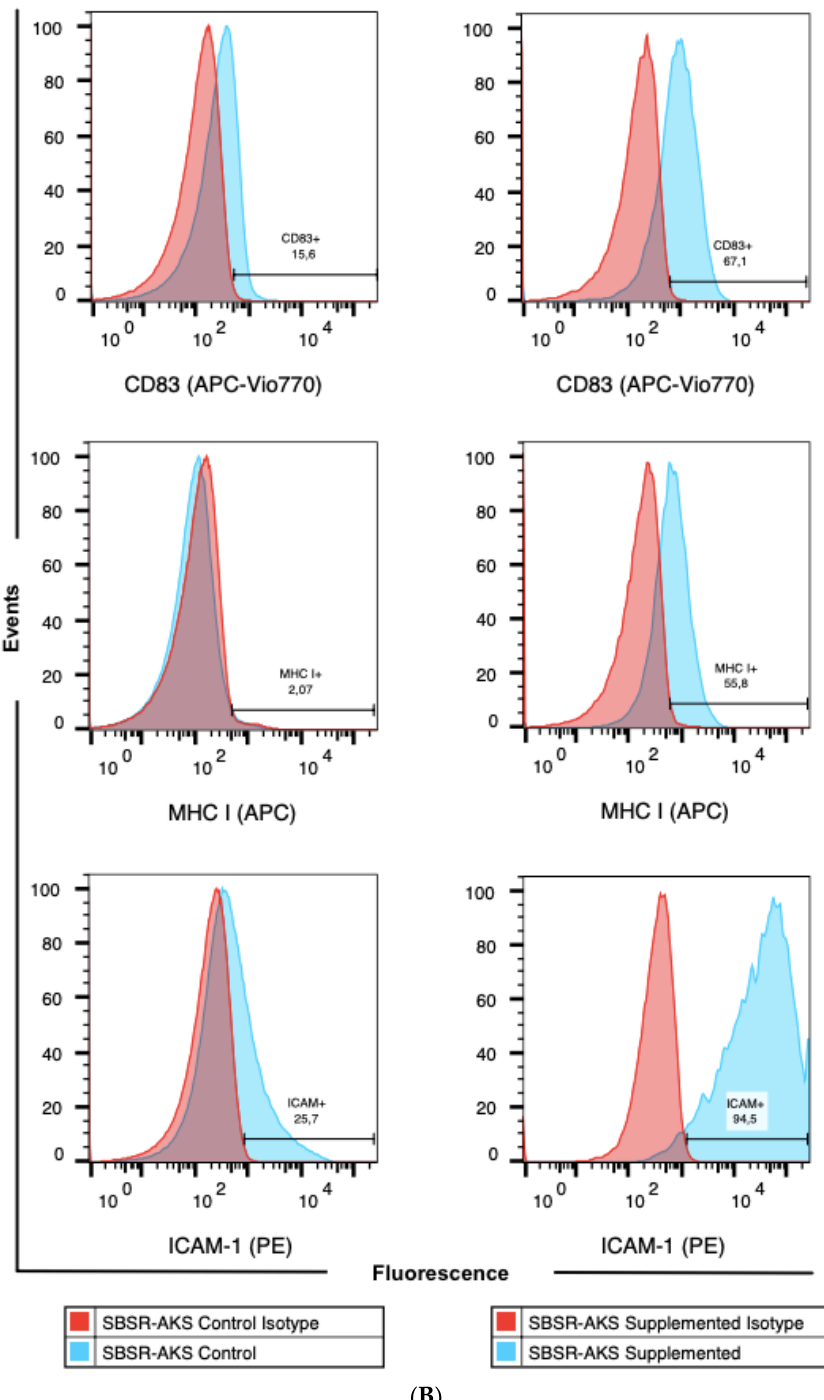
Figure 2. Upregulation of immunogenic cell surface markers by DC cytokines. ( A ) A673 CD83, MHC class I, and ICAM-1 expression are upregulated in supplemented (right) versus control cells (left). The gates were set according to isotype-labeled control samples. ( B ) SBSR-AKS CD83, MHC class I and ICAM-1 expression are upregulated in supplemented (right) versus control cells (left). Gates were set according to the IgG-isotype control (red histogram) and compared to the antibody-labelled cells (blue histogram).